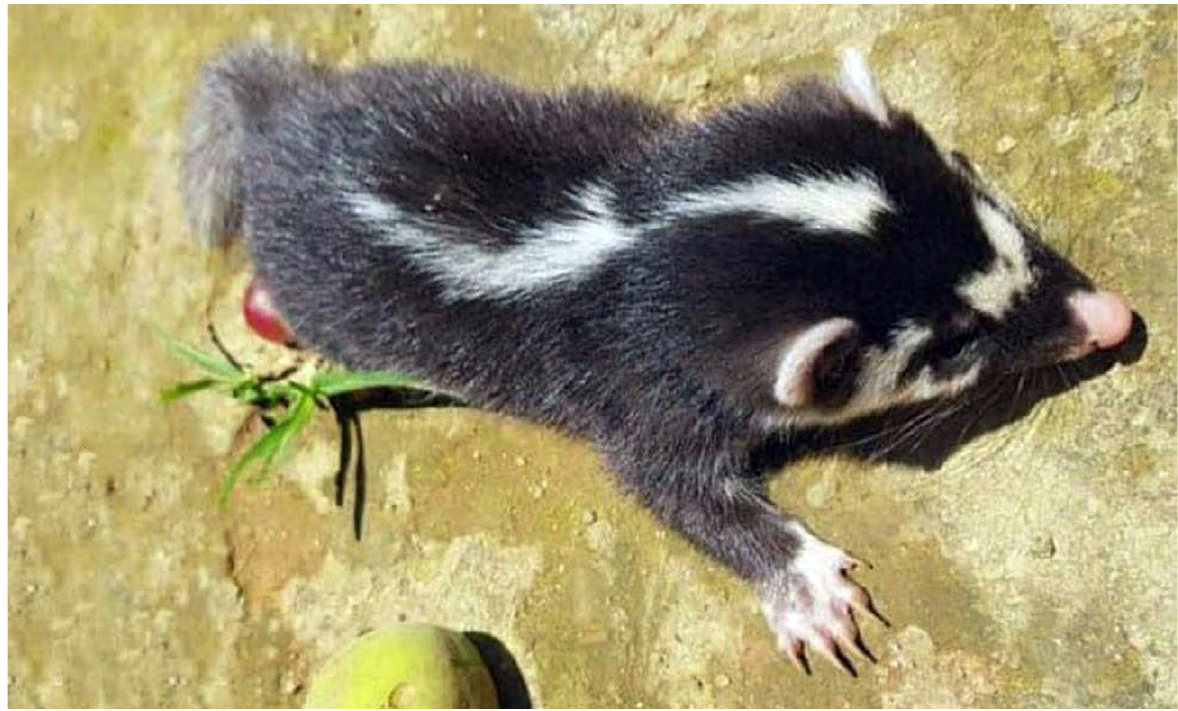
Figure 2. Melogale personata in Waling, Syangja District, Nepal (photograph: Komal Raj